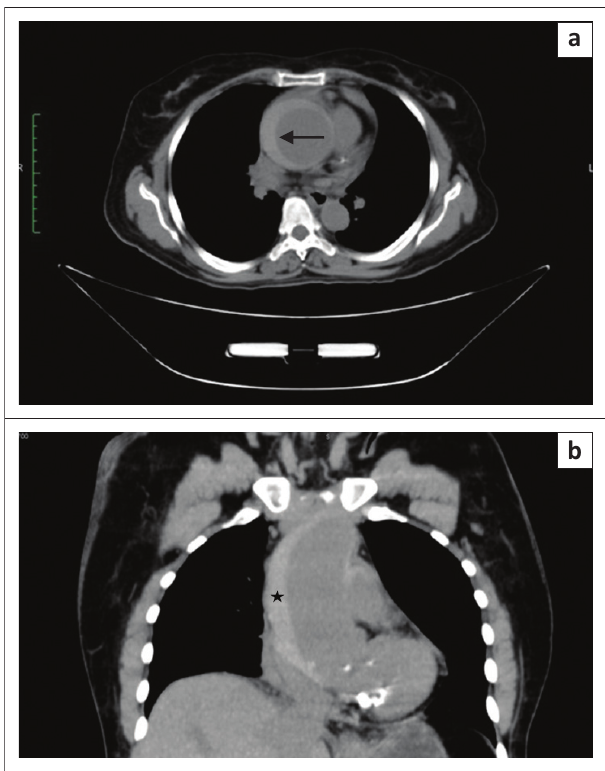
FIGURE 6: Stanford type A intramural haematoma (IMH): (a) Unenhanced axial computed tomography (CT) scan showing hyperdense crescentic aortic wall thickening involving the ascending aorta (arrow); (b) Stanford type A IMH. Unenhanced coronal CT scan showing crescentic hyperdense aortic wall thickening ( * ) compressing the lumen.